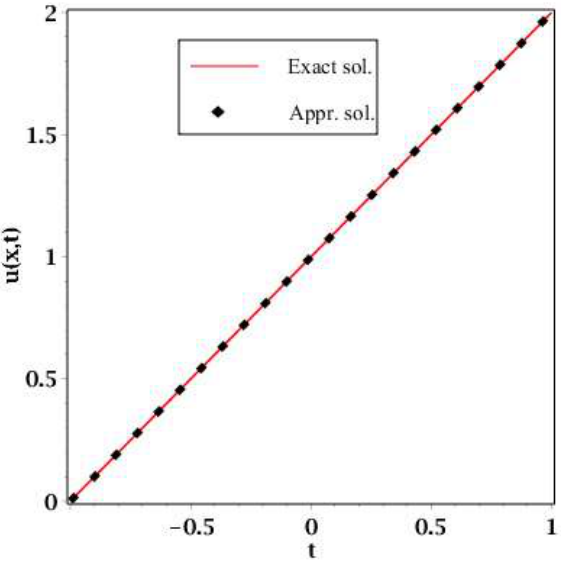
Fig. 3: Comparison between exact solution and approximate solu- tion when α =